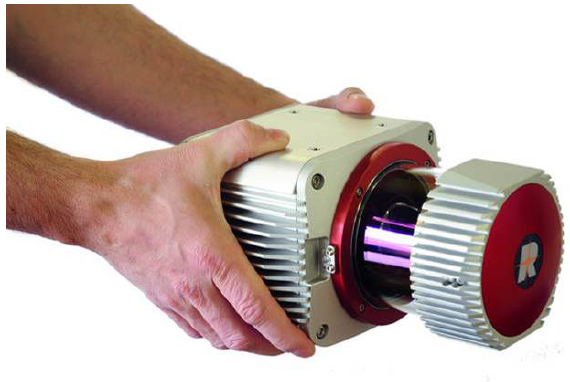
Figure 3: RIEGL VUX-1UAV laser scanner